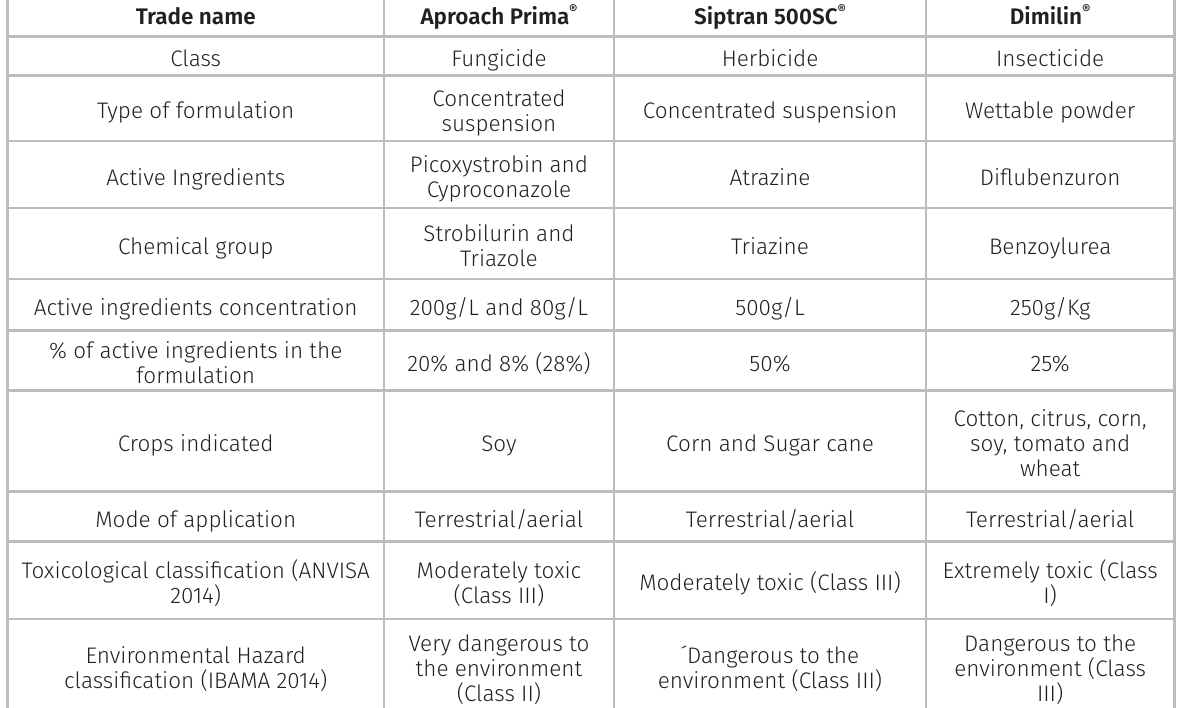
Table I. General characteristics of the pesticides tested, indicated crops, mode of application and toxicological and environmental hazard